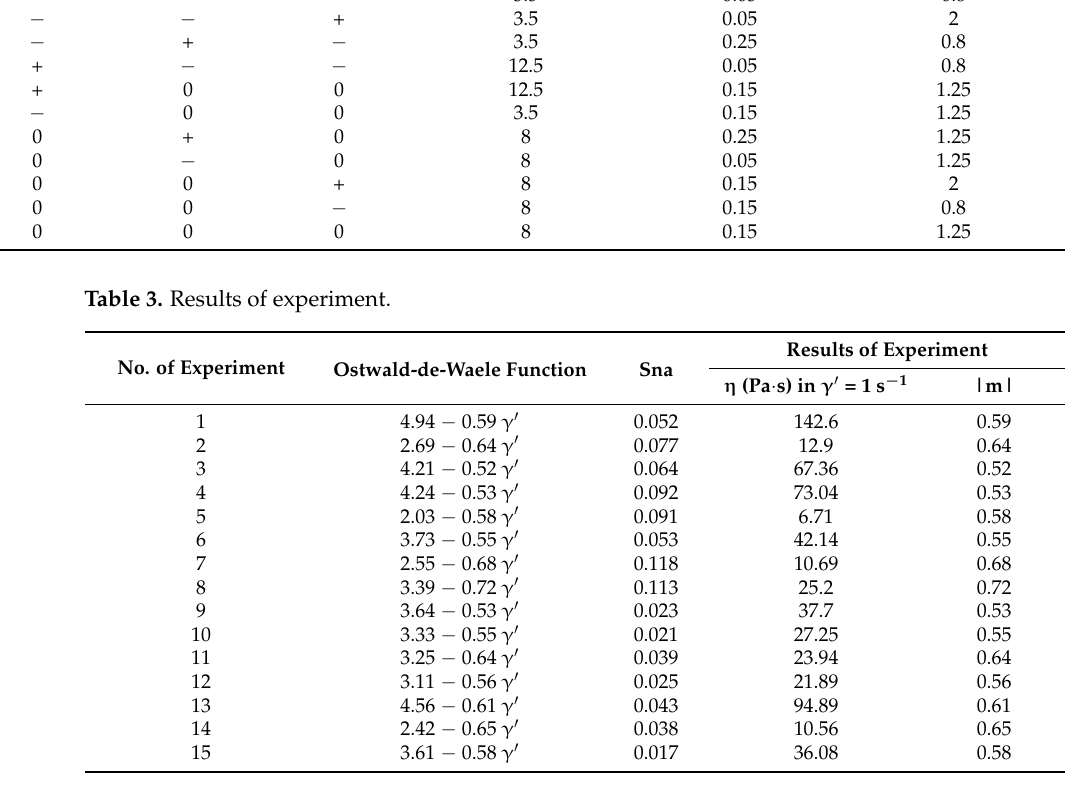
Table 4. The relative increase in viscosity of